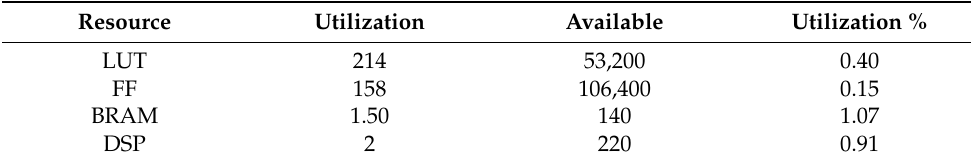
Figure 7. Block diagram of a specialized computing device for determining the parameters of the approximating dependence. Table 1. Using the resources of FPGA XC7Z7020 when implementing one module for calculating the probability of a hypothesis.